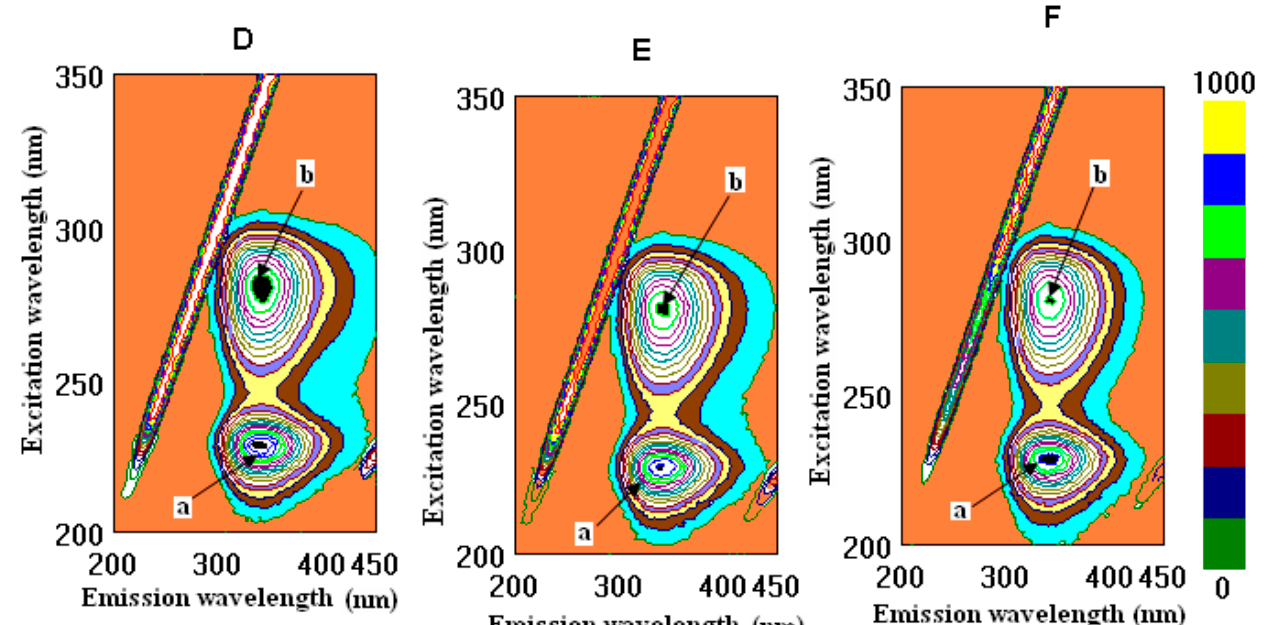
Figure 1. Fluorometric measurements in a three-dimensional fluorescence analysis (3D-FL) of red wine samples and standards after interaction with fibrinogen Cross-images of the results obtained from the 3D-FL of the investigated samples after interaction with fibrinogen are shown in the following order: ( A ) CSCarmel2; ( B ) CSYarden2; ( C ) tannic acid; ( D ) quercetin; ( E ) caffeic acid; ( F ) fibrinogen in solution. Abbreviations: CSCarmel2, Cabernet Sauvignon Carmel Selected, vintage 2019; CSYarden2, Cabernet Sauvignon Golan Heights Winery Yarden, vintage 2019. The locations of peaks a and b are shown in the figure and in Table 2 (for interpretation of the references to color in this figure legend, the reader is referred to the web version of this article).